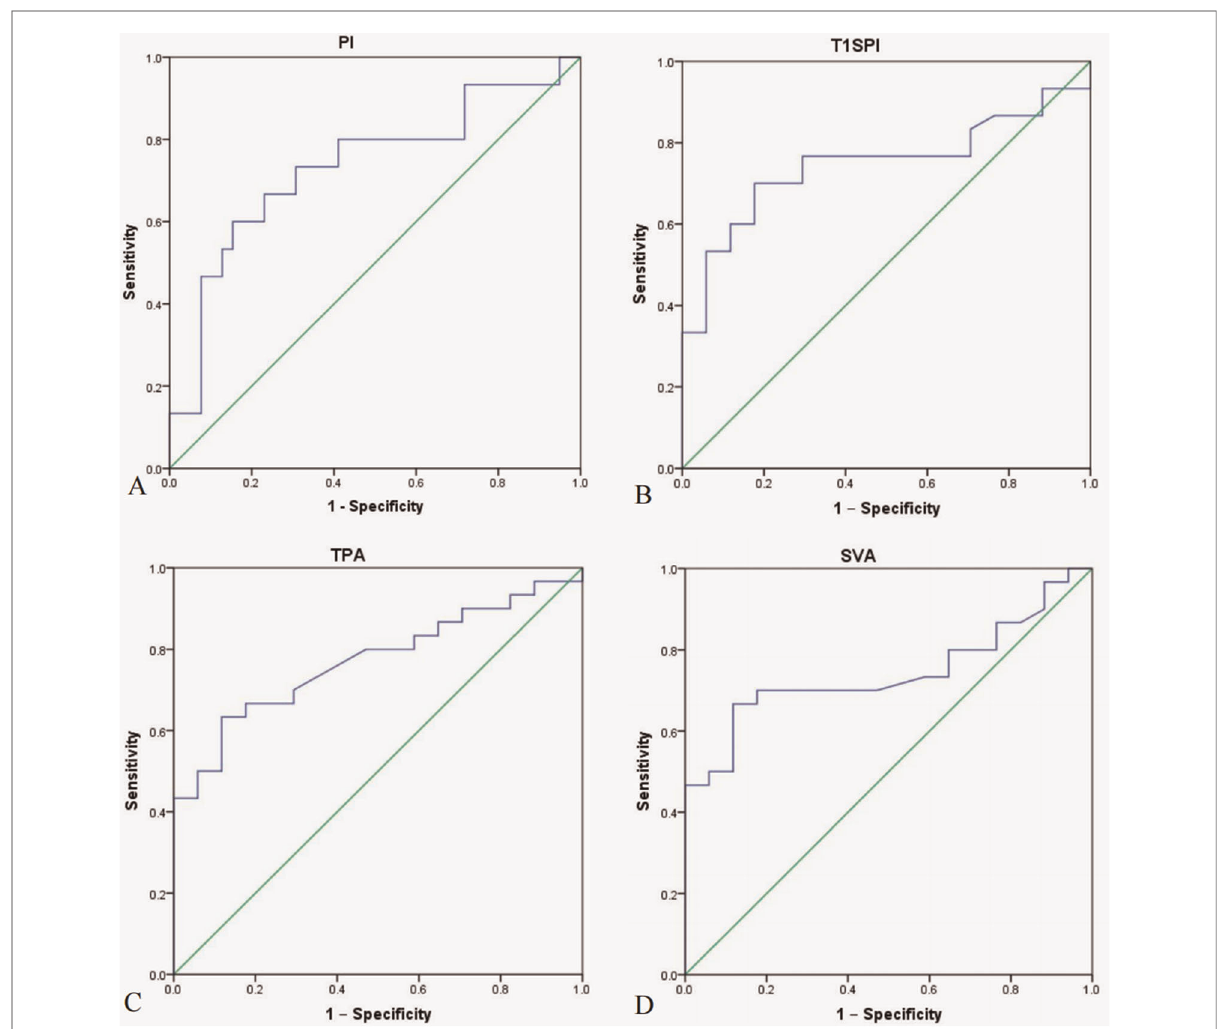
FIGURE 3 Receiver operating characteristic (ROC) curve analysis of clinically relevant parameters for the optimal threshold value. ( A ) The area under curve (AUC) for pelvic incidence (PI) was 0.733, the optimal threshold of PI was ≤ 49.2° for obtaining good clinical outcome with sensitivity of 73.3% and false- positive rate (1-Speci fi city) of 30.8%. ( B ) The AUC for T1 spinopelvic inclination (T1SPI) was 0.746, and the optimal threshold of T1SPI was ≤ 0.9° for obtaining a good clinical outcome with a sensitivity of 70.0% and a false-positive rate of 17.6%. ( C ) The AUC for T1 pelvic angle (TPA) was 0.772, and the optimal threshold of TPAwas ≤ 31.5° for obtaining good clinical outcome with a sensitivity of 63.3% and a false-positive rate of 11.8%. ( D ) The AUC for sagittal vertical axis (SVA) was 0.741, and the optimal threshold of SVA was ≤ 9.3 cm for obtaining good clinical outcome with a sensitivity of 66.7% and a false-positive rate of 11.8%.